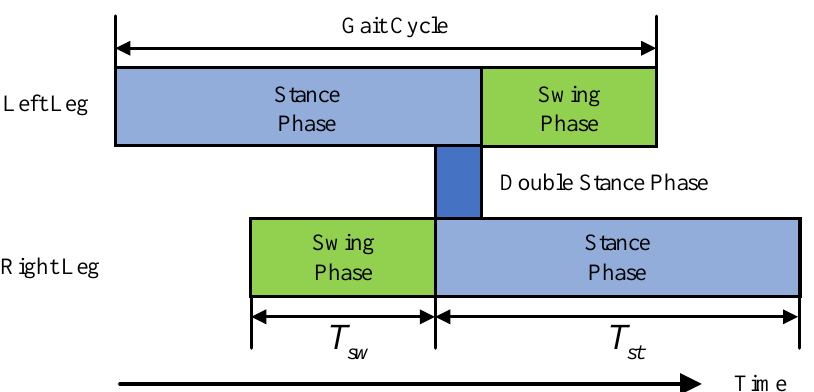
Figure 3. The walking gait pattern generated by the